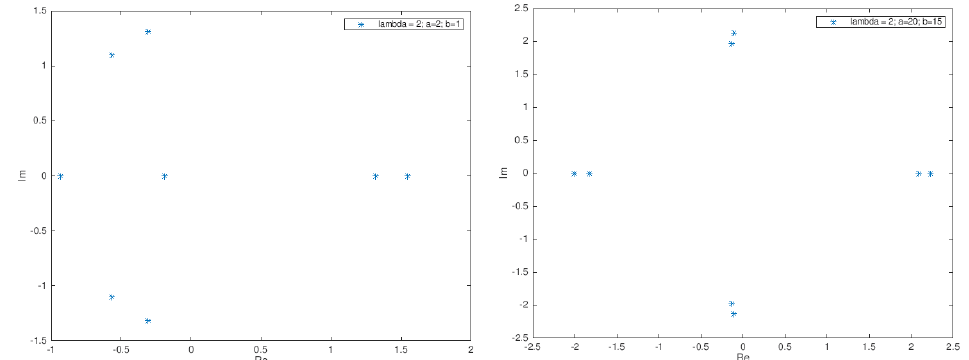
Figure 9. Homotopy graph for λ = 2 and different values for a , b . Note that the complex conjugate eigenvalues converge to the imaginary axis.